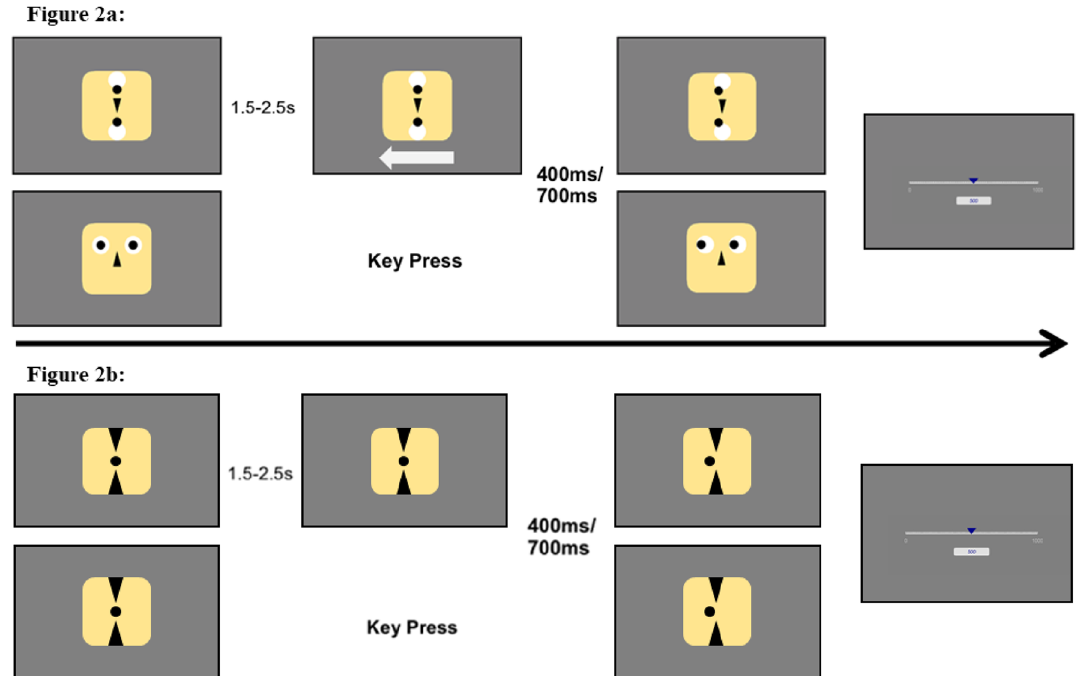
Figure 2. Trial Event Structure. ( a ) shows the set-up of Experiment #1 for the physical-observant (top row) and the personal-operant (bottom row) trials. ( b ) shows the set up of Experiment #2 for the observant (top row) and the operant trials. Top row Trials started with the depiction of the respective stimulus. For observant conditions an arrow appeared after 1.5–2.5 s to indicate movement direction and to serve as the start event for the following duration judgement. After either 400 ms or 700 ms the stimulus moved its dot(s)/eyes to the left or right depending on indicated direction. Lastly, participants estimated the duration between arrow presentation and stimulus movement using a visual analogue scale. Bottom Row Trials started with the depiction of the respective stimulus. For operant conditions, participants freely pressed one of two buttons indicating a movement direction and to serve as the start event for the following duration judgement. After either 400 ms or 700 ms the stimulus moved its dots/eyes to the left or right depending on indicated direction. Lastly, participants estimated the duration between key press and stimulus movement using a visual analogue